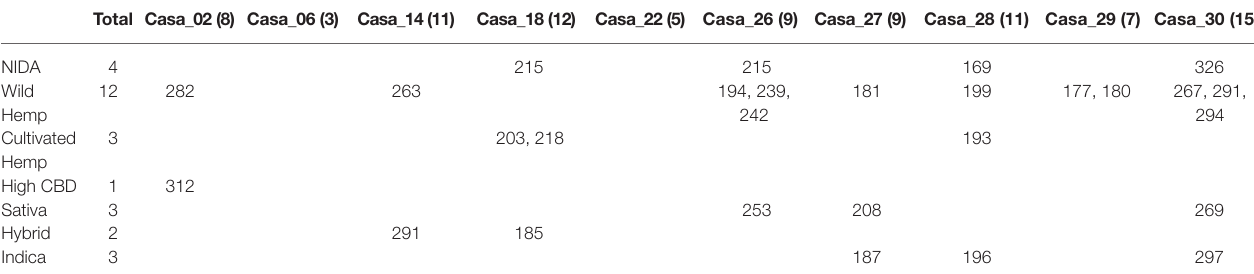
TABLE 2 | Private alleles in each categorical group for ten loci. The number in parentheses after the locus name is number total number alleles for a